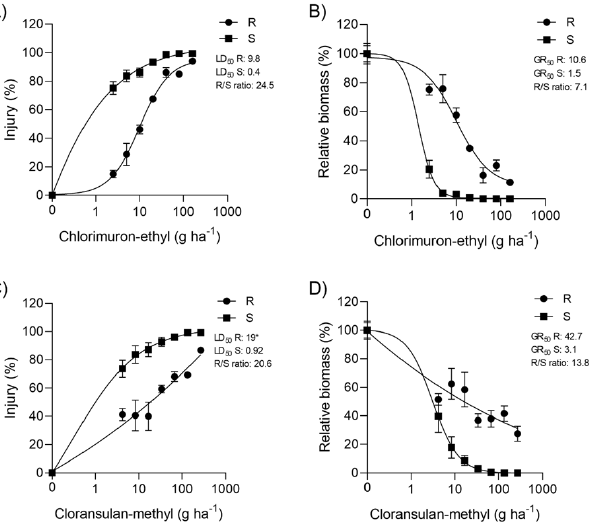
Figure 2. Dose-response curves for chlorimuron-ethyl ( A , B ) and cloransulam-methyl ( C , D ) in populations resistant (R) and susceptible (S) to ALS inhibitors ( Erigeron sumatrensis ).